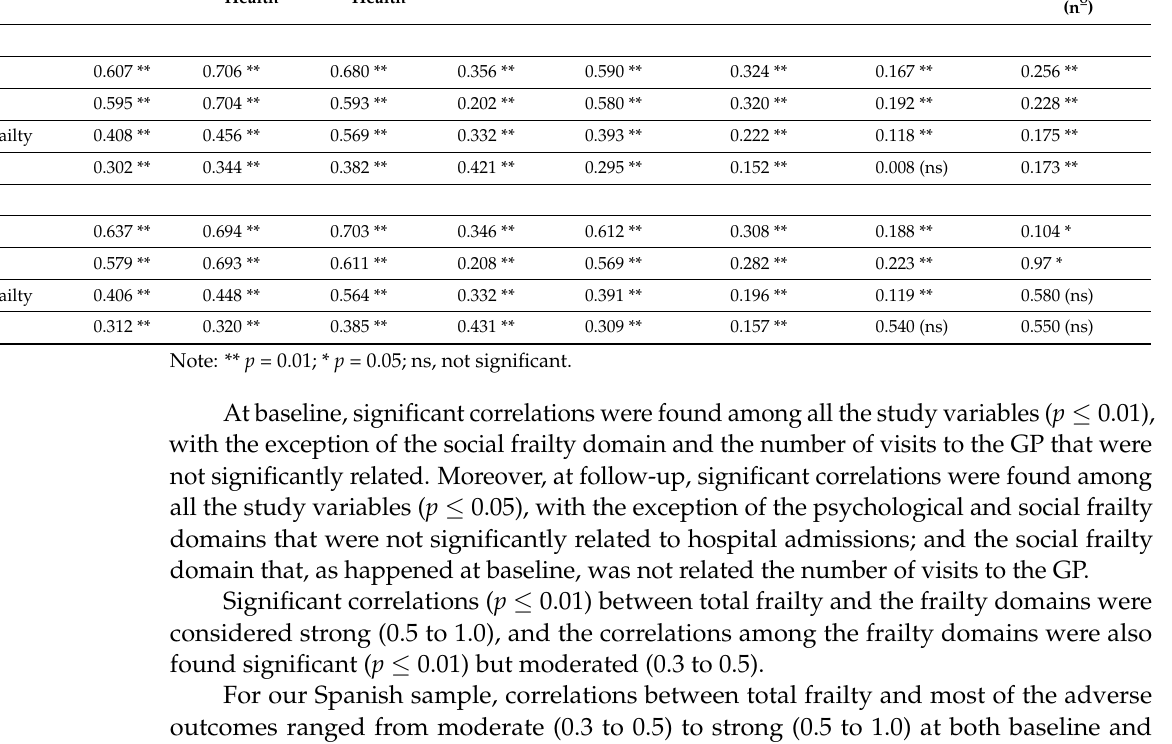
Table 1. Characteristics of the Participants (N =